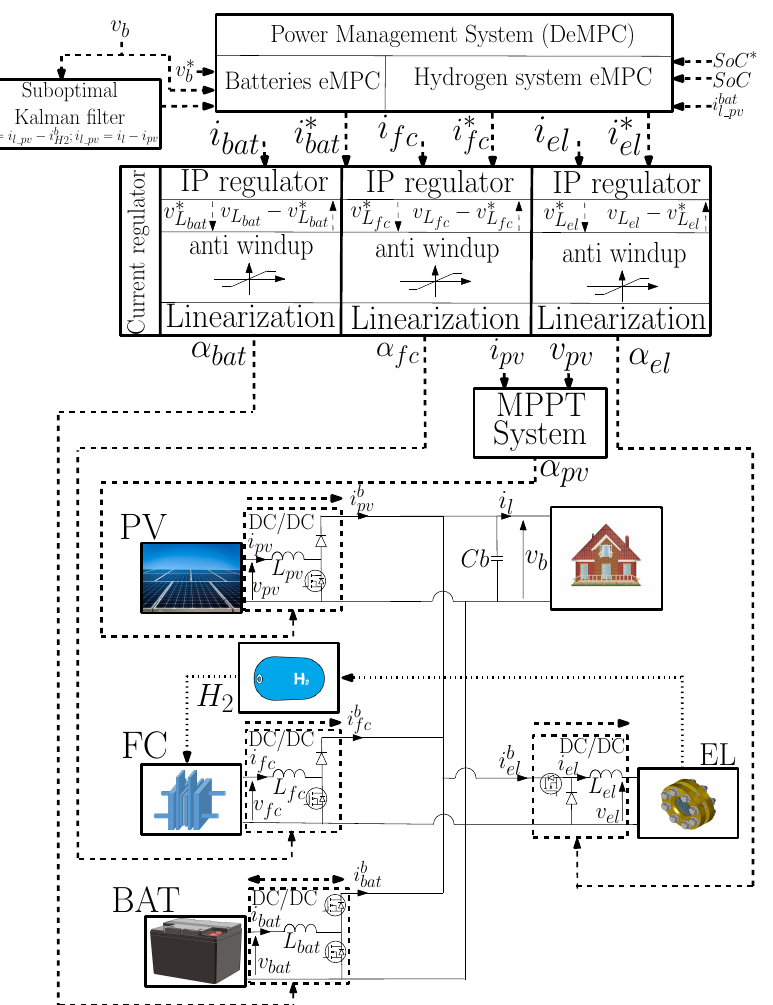
Figure 1. Micro-grid structure